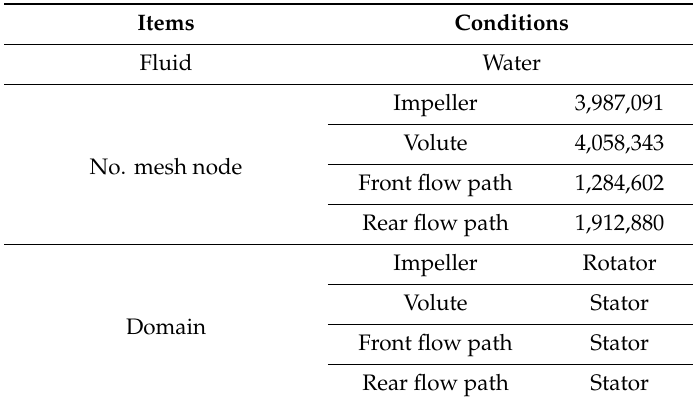
Table 2. CFD analysis boundary conditions of Type A pump